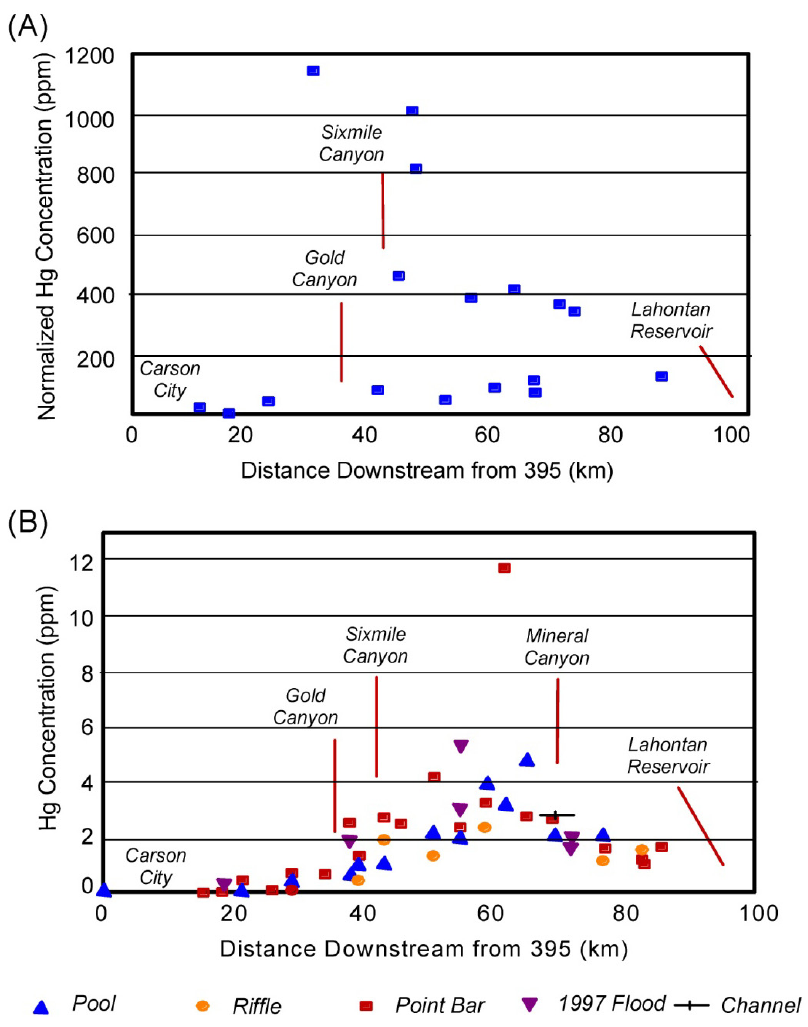
Figure 3. ( A ) Downstream variations in Hg concentration normalized for silt and clay percent measured within the alluvial valley fill of the Carson River valley, western Nevada. Increased Hg concentrations occur in response to the influx of Hg from amalgamation processing mills. Variations result from distance from mills of sampling sites, age of stratigraphic units relative to Ag/Au production and Hg influx, hydrologic conditions at time of deposition and other factors; ( B ) Downstream variations in Hg concentration within channel bed sediments. Concentrations within the modern channel sediments gradually increase as contaminated materials are eroded from the channel banks. The decline in concentration results from the influx of “clean” sediments from tributaries and from the erosion of uncontaminated bank materials (modified from Miller et al.